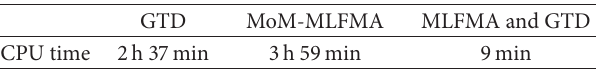
Table 2: Comparison of the CPU time for the analysis of the Passat test case.